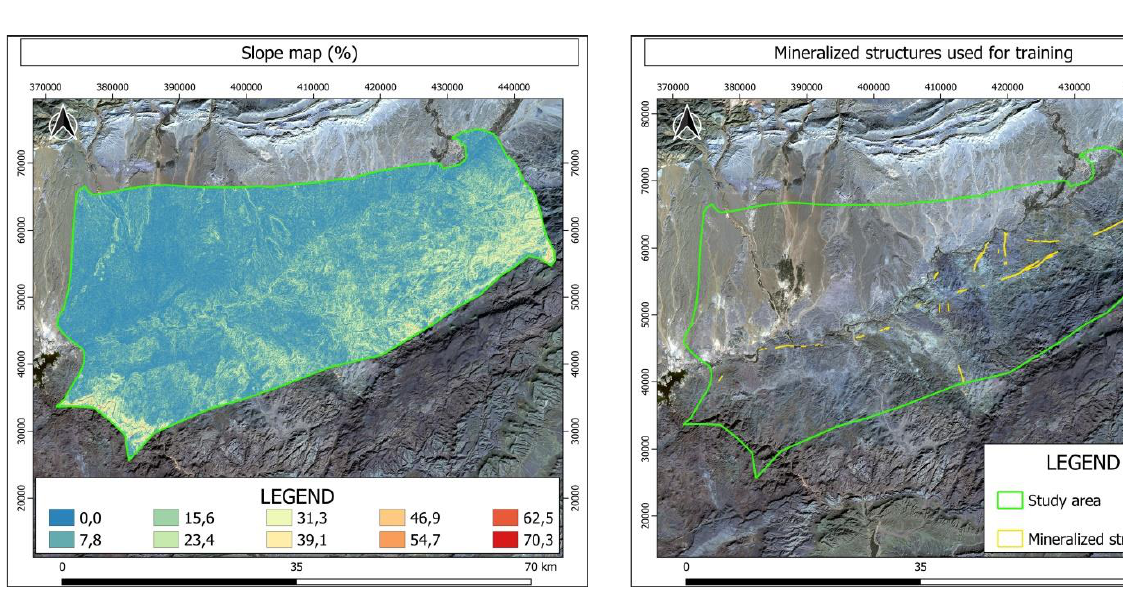
Figure 7: Map of pre-existing Indicator minerals in the study area. Each pixel in the Mineralized structures takes a value of 1 and the rest pixel values takes 0. Then each pixel was used as the labeled data for the models.